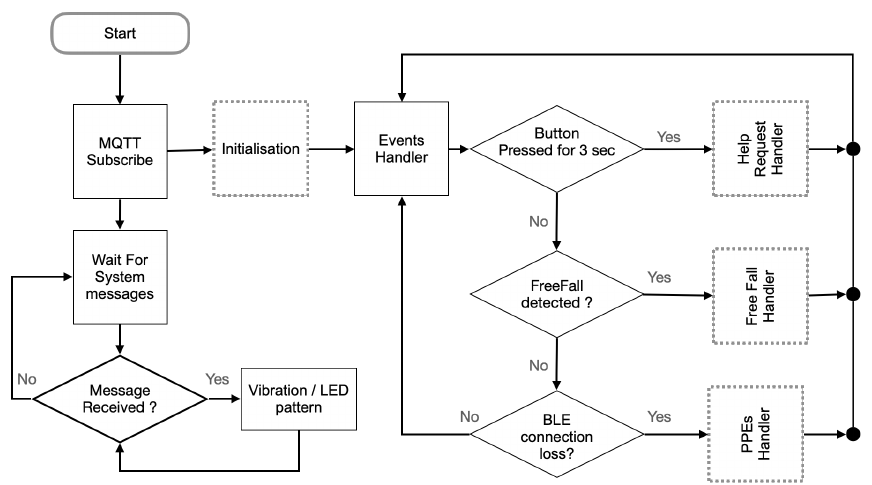
Figure 11. Belt-Device firmware flowchart.